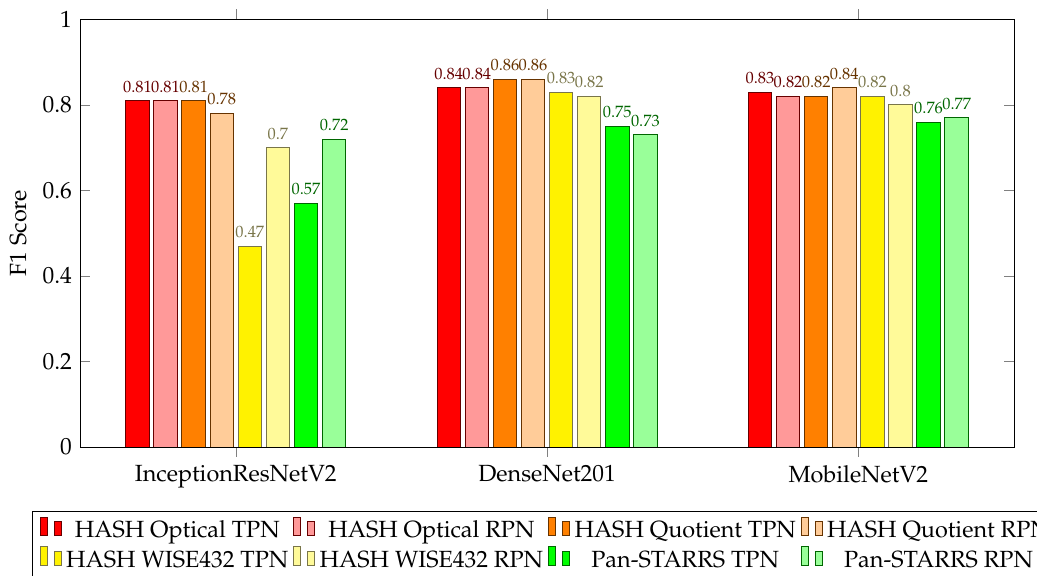
Figure 7. The trained model evaluation F1 Score for PNe True and Rejected classification using images from HASH DB and Pan-STARRS Test